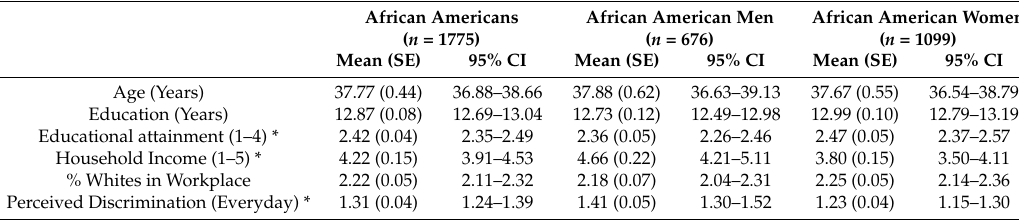
Table 1. Descriptive statistics in the pooled sample of employed African Americans.